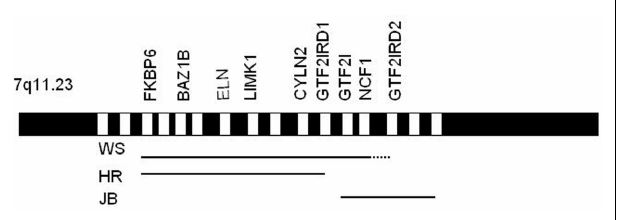
FIGURE 1 |Williams syndrome region. Lines represent the regions typically deleted in patients withWS, and the individual deletions of HR and JB. Only some of the main genes are shown. (Not drawn to